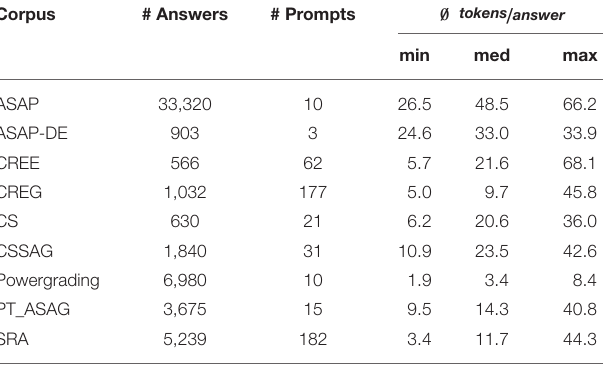
TABLE 1 | Dataset statistics.